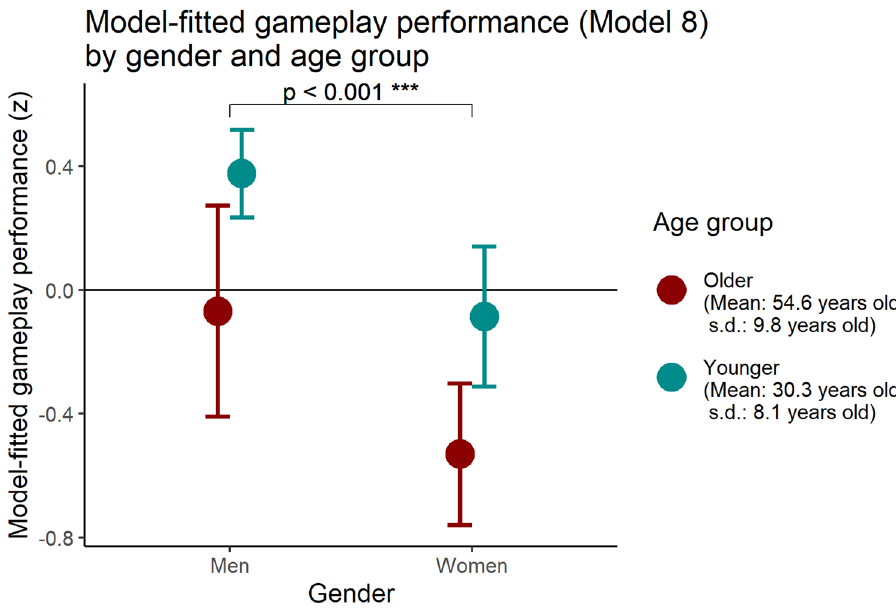
Figure 4. Model-fitted in-game performance as a function of age group and gender, controlling for input multi- tasking and actual age (age was set to 40, the mean, for the comparison). Final model (model 8)